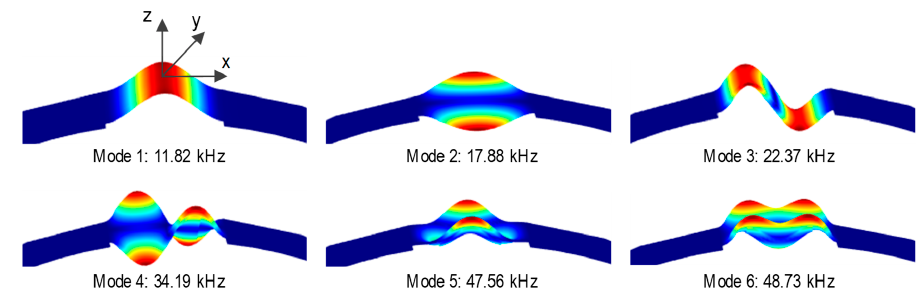
Figure 9. Eigen-modes of hoop-type PZT interface.